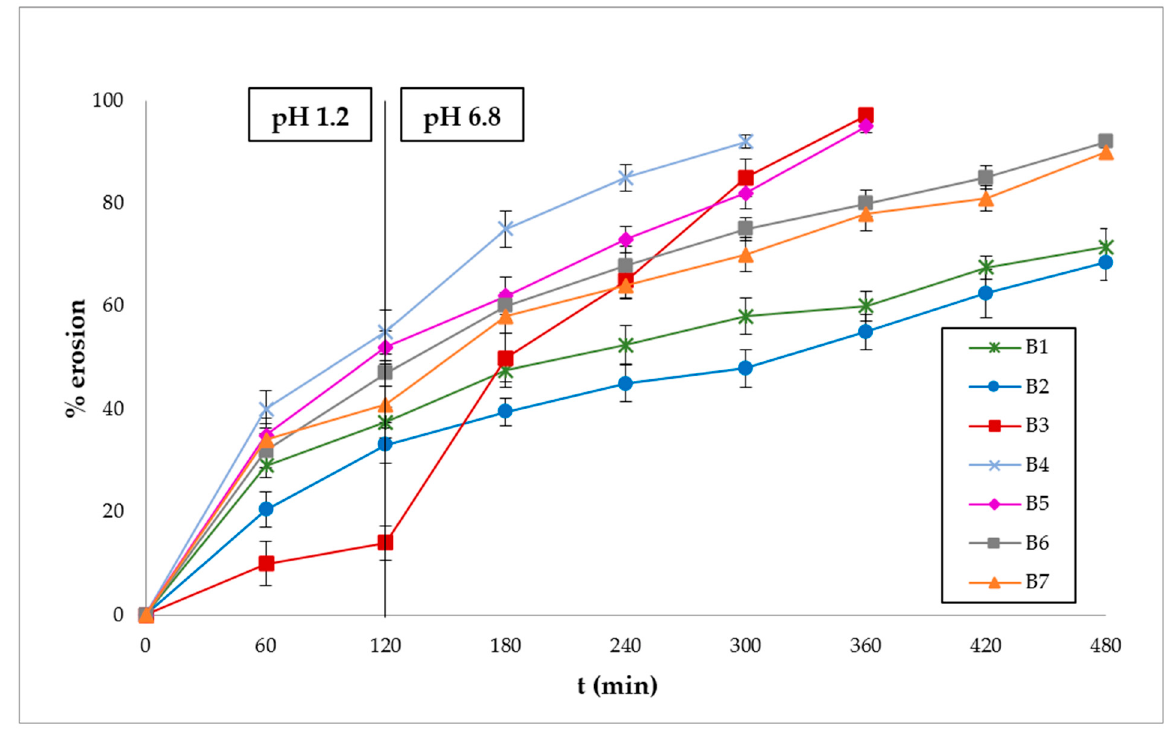
Figure 4. % Erosion of BUP·HCl tablets formulations vs. time at pH 1.2 (0–120 min) and at pH 6.8 (120–480 min). The results denote the mean value ( n = 6).